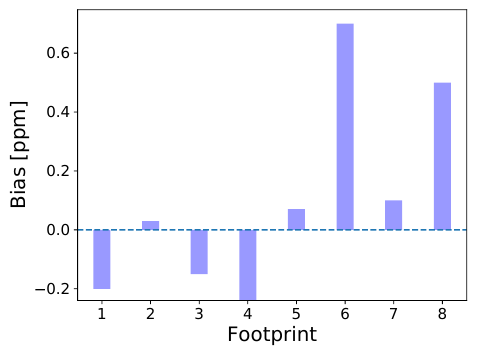
Figure 3. Estimated swath-dependent biases using Target mode ob-